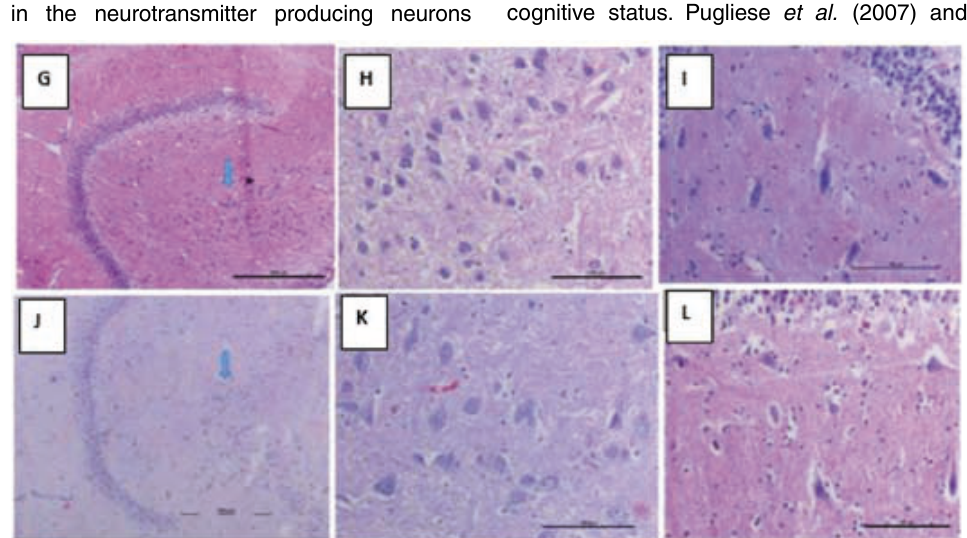
Figure 3. Distribution of neurons in the hilar region of dog hippocampus. G. Numerous neurons in 4 months old (Case No. 59/21). H. More neurons in 1 year old (Case No. 287/21. I. Pyknotic neurons in 2 years old (Case No. 140/21). J. Reduction in the number of neurons in 8 years old (Case No. 287/21). K. Lesser neurons in 10 years old (Case No. 218/21). L. Marked reduction in neurons in 7 years old (Case No. 11/21). (G & J :100X, H, I, K&L: 400X).